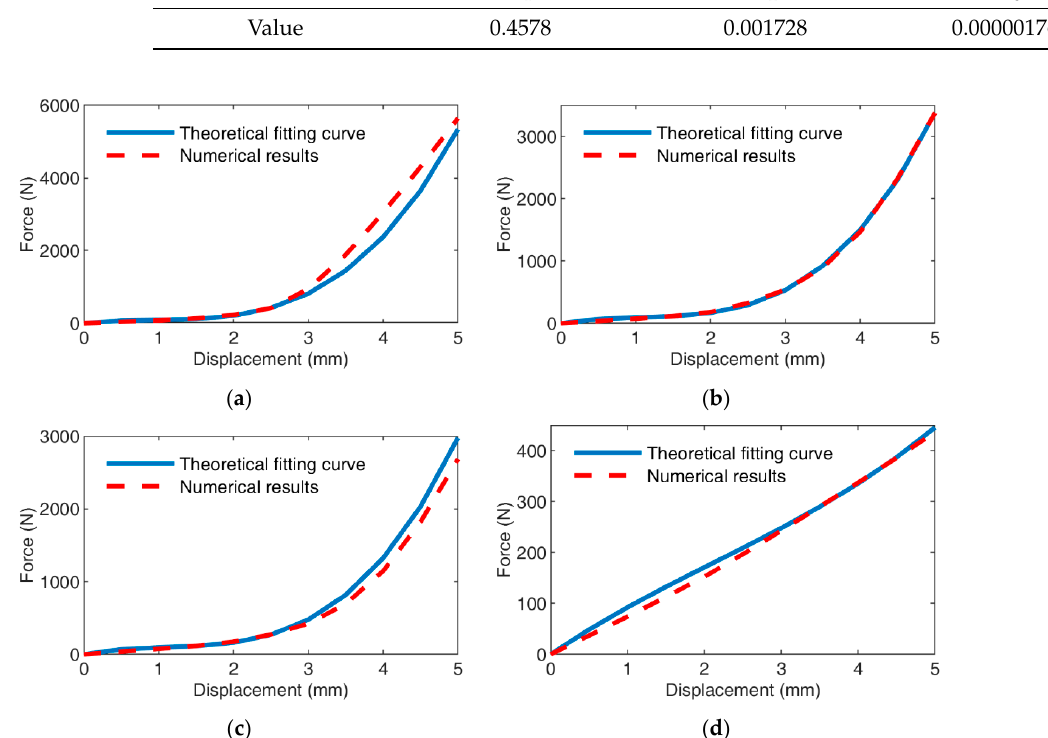
Figure 13. Fitting curves for the braided corrugated hose: ( a ) 41° ; ( b ) 45° ; ( c ) 46° ; ( d ) d = 0.3. With braiding angles of 41° , 45° , and 46° , the theoretical fitting curves matched the numerical results well. Some points did not match exactly; the maximum error occurred at the braiding angle of 41° , which was 21.9%. The reasons for the errors were due to changes in the diameter of the metal wire when subjected to tensile load, although it was assumed that the diameter of the wire remained constant. When the diameter of the wire was 0.3 mm, the theoretical fitting curve also matched the numerical results well. Some errors were caused by not considering the radial variation of the wire. 5. Conclusions In this paper, a nonlinear axial stiffness model of a braided corrugated hose is established based on the energy method and the curved beam model. The simulation experimental results are used to fit the established axial stiffness model of the braided corrugated hose and the fitting coefficients are determined. The theoretical fitting curve and the simulation curve show good agreement, while the established axial stiffness model can describe the nonlinear mechanical properties of the braided corrugated hose well. In addition, the established axial stiffness model of the braided corrugated hose can also reflect the influence of the braiding angle, wire diameter, and other related parameters on its nonlinear mechanical properties, thereby allowing prediction of the structural stiffness, providing a theoretical basis for the production and design of the braided corrugated hose. These results will have important significance, guiding practical applications in pipeline engineering. Author Contributions: This study was initiated and designed by D.H. The numerical simulations, data analysis, and writing of the paper were completed by D.H., while J.Z. provided suggestions regarding the research design and writing of the paper. All authors have read and agreed to the published version of the manuscript. Funding: This research was funded by the National Key Research and Development Plan, grant number no. 2019YFB2006402.